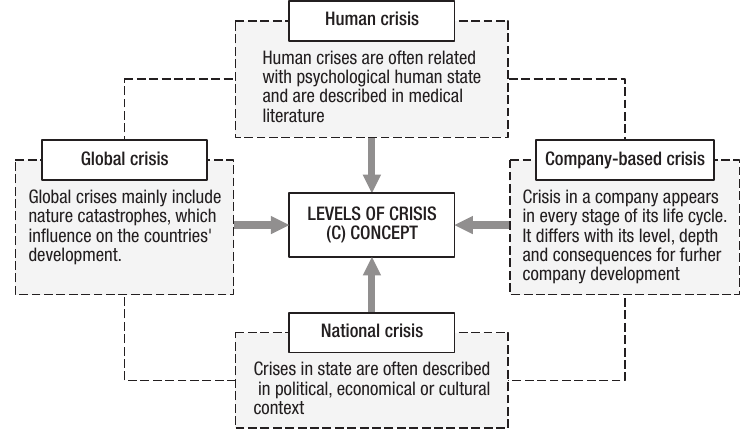
Fig. 1. Levels of crisis concept (modi fi ed by the authors) Table 1. Positive and negative aspects of crisis expression (modi fi ed by the authors) Crisis position Negative aspects Positive